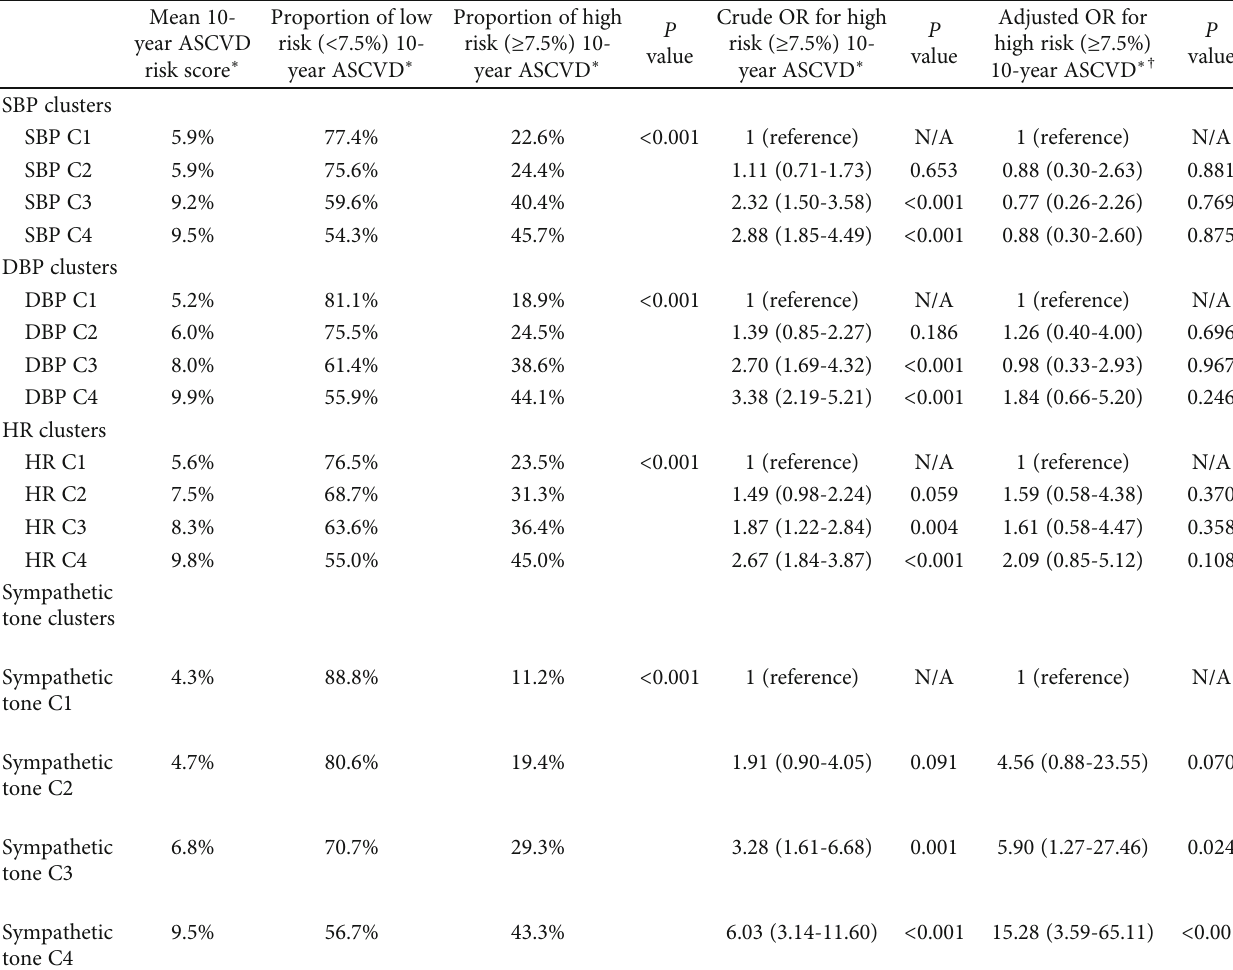
Table 3: Estimated 10-year ASCVD risk according to the SBP, DBP, HR, and sympathetic tone clustering